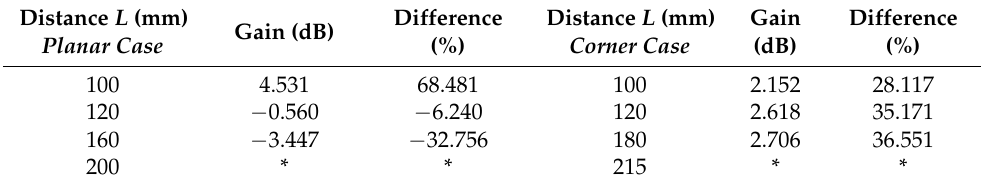
Table 1. Difference of signal amplitudes with respect to maximum distance (*—reference value).